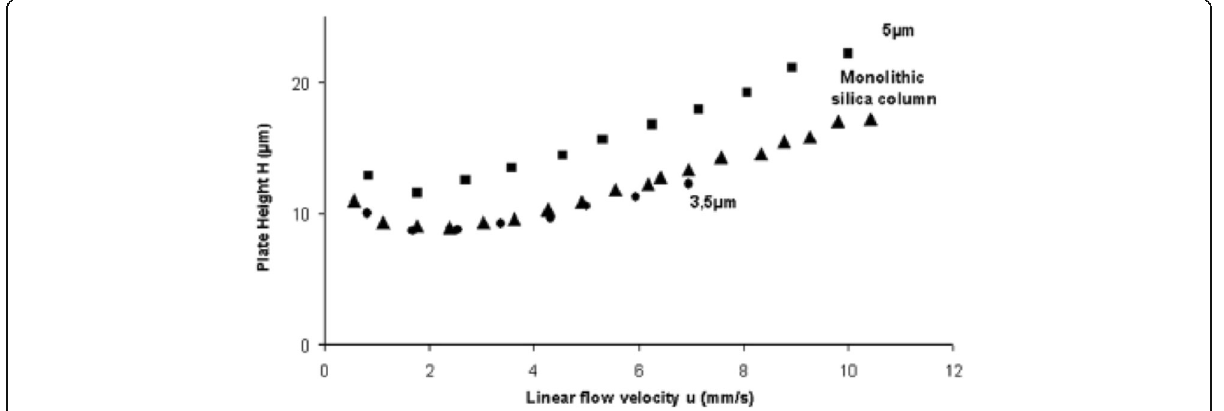
Fig. 4 van Deemter curves for the conventional and monolithic columns (Cabrera,